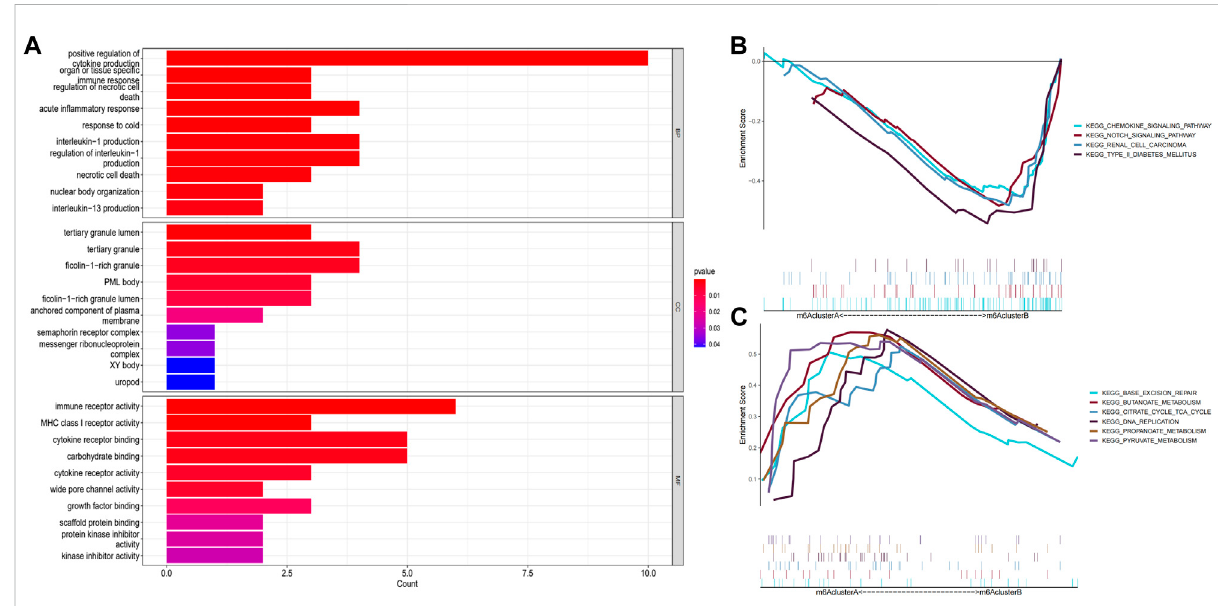
FIGURE 6 Enrichment analysis ofgene expressionin samples. (A) Graph showing theGeneOntology (GO) analysisof the related pathways underlying the effectofthe87m6A-relateddifferentiallyexpressedgenes(DEGs)inpatientswithepilepsy. (B,C) GeneSetEnrichmentAnalysis(GSEA)topredictthe pathway of DEGs affecting the occurrence and progression of epilepsy ( p < 0.05).